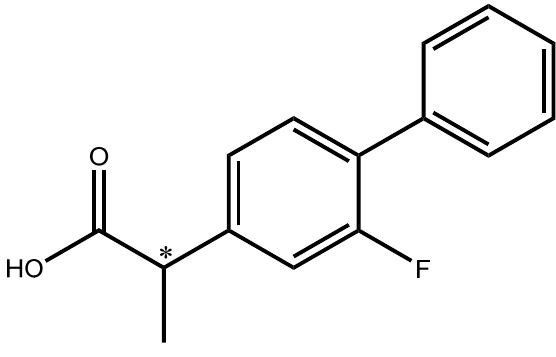
Figure 2. Structural formula of